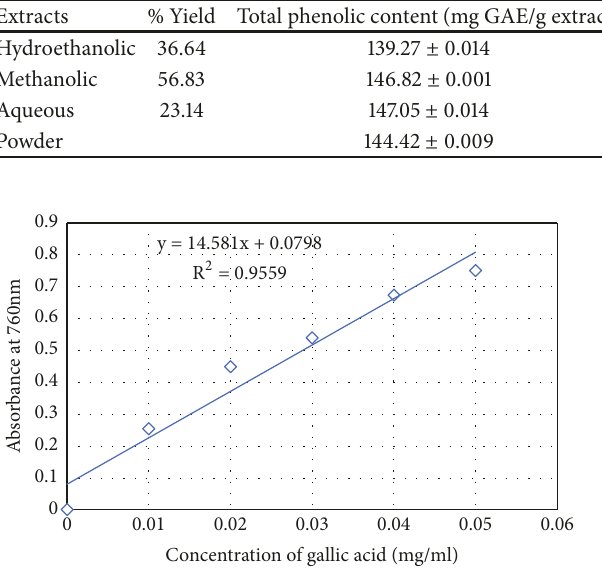
Figure 2: Calibration curve of gallic acid in determination of total phenolic content of C. edulis .